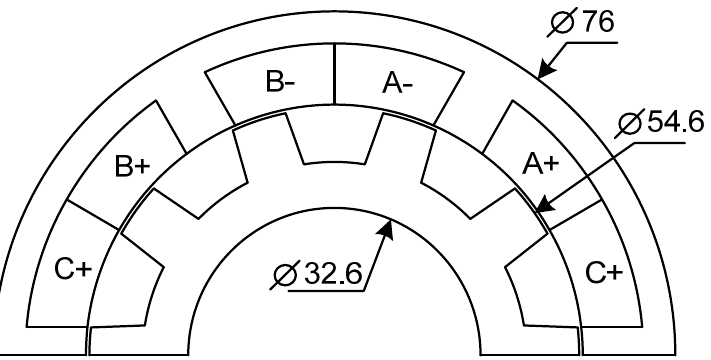
Figure 24. Half of optimal 6/10 SRM configuration geometry with main dimensions in millimeters.